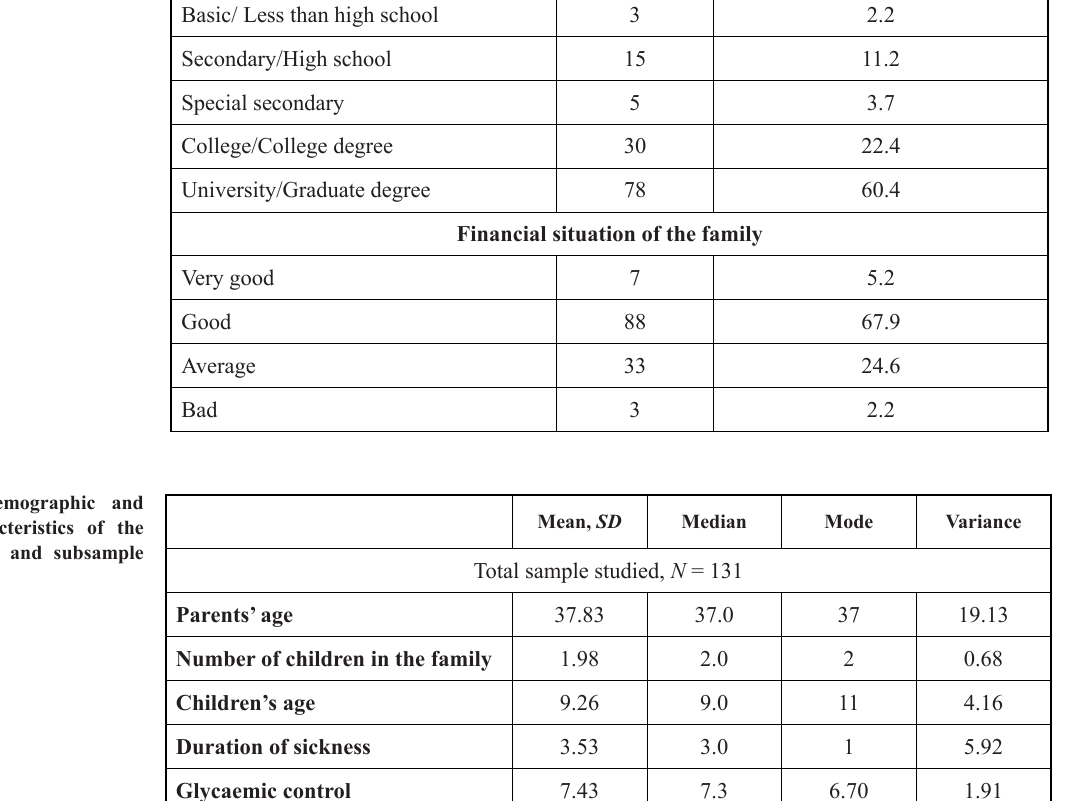
Table 2. Demographic and social characteristics of the total sample and subsample studied